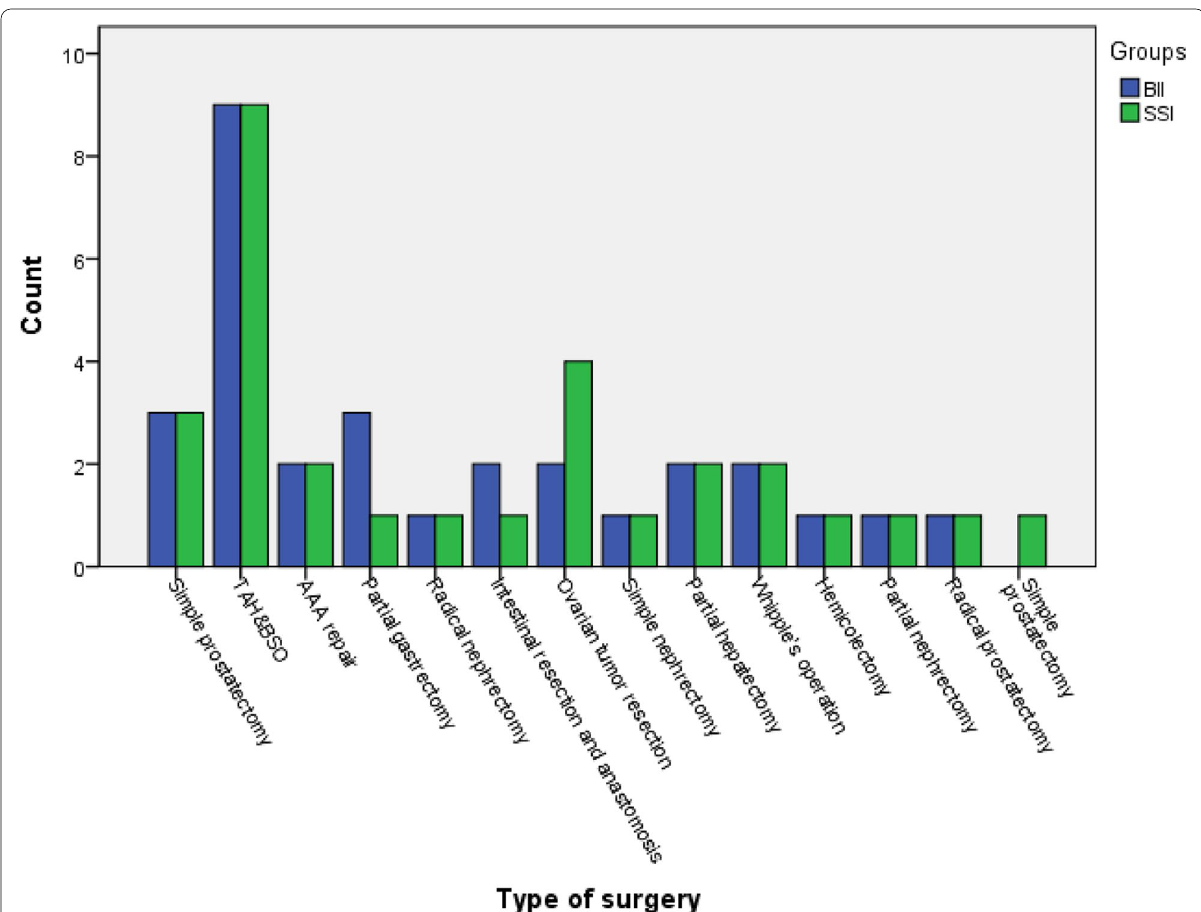
Fig. 2 Frequency distribution of the different types of surgeries. BII: Bolus‑insulin infusion group, SSI: Sliding scale of insulin